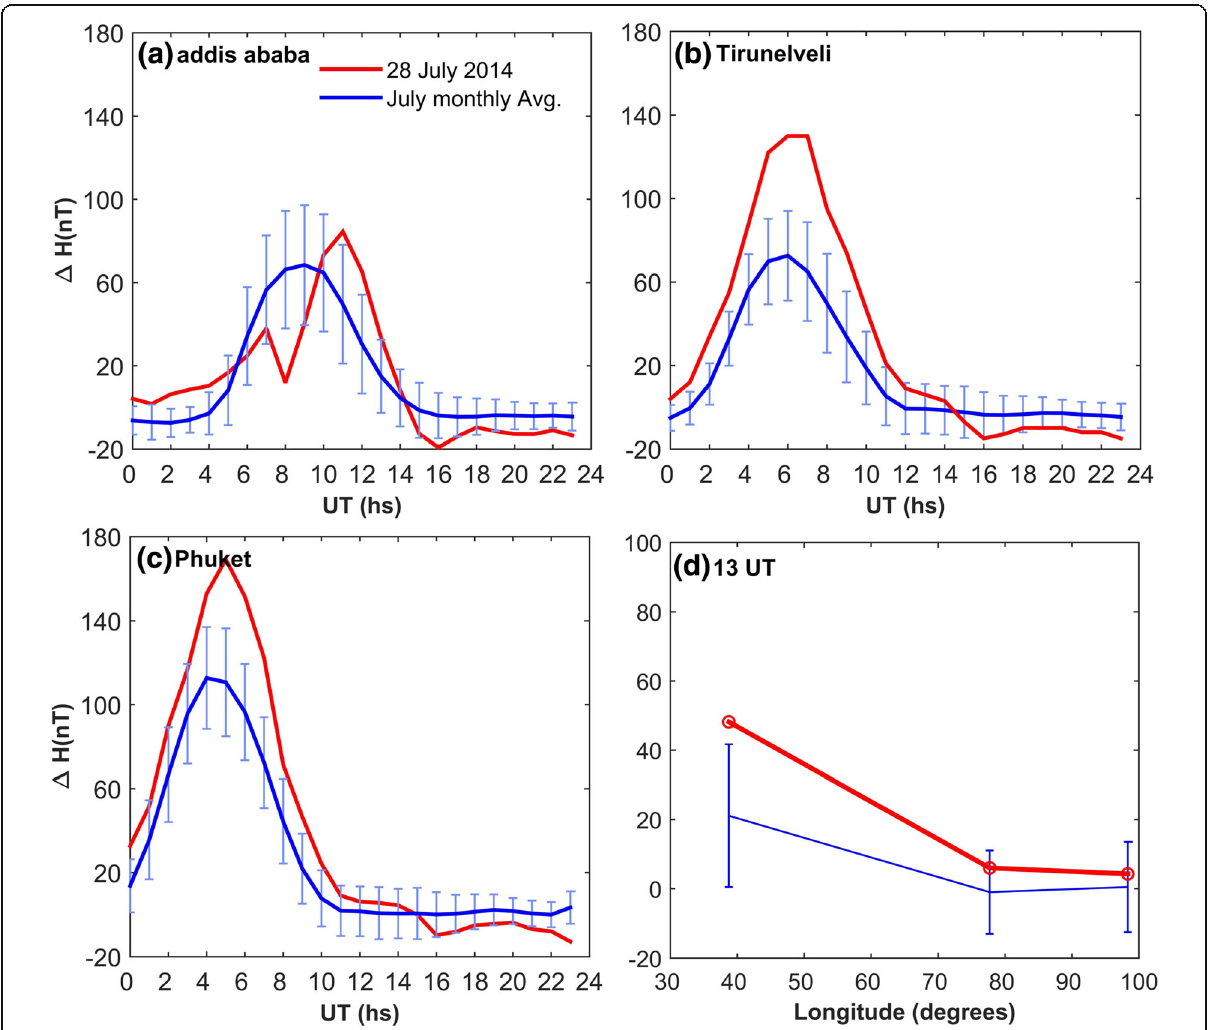
Fig. 8 The Δ H variation as a function of universal time on 28 July 2014 (red line) and July monthly average (blue line with error bar) observed by magnetometers over a Addis Ababa, b Tirunelveli, and c Phuket and d the longitudinal variation of Δ H values for 13